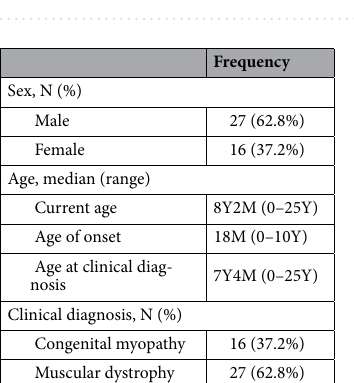
Figure 1. Patient enrolment workflow.